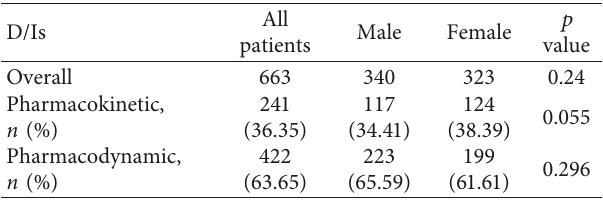
Table 2: Distribution of drug interactions based on mechanism (pharmacokinetic and pharmacodynamic interactions).